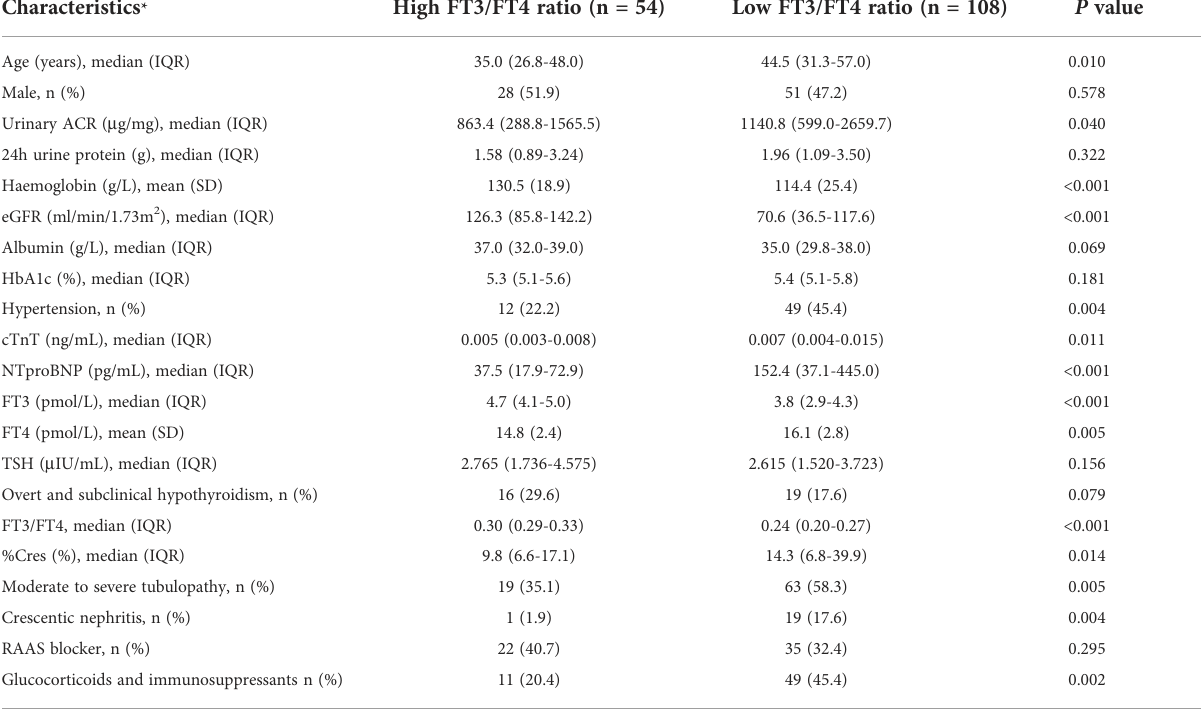
TABLE 1 Characteristics of patients classi fi ed according to the FT3/FT4 ratio.